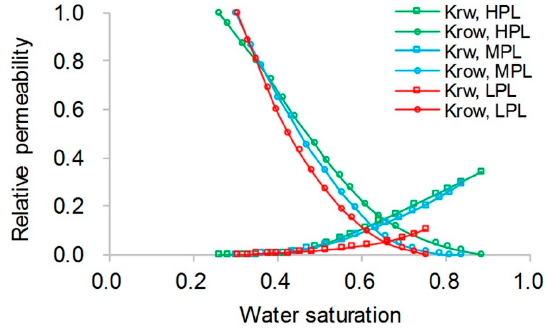
Figure 7. Relative permeabilities without polymer degradation.